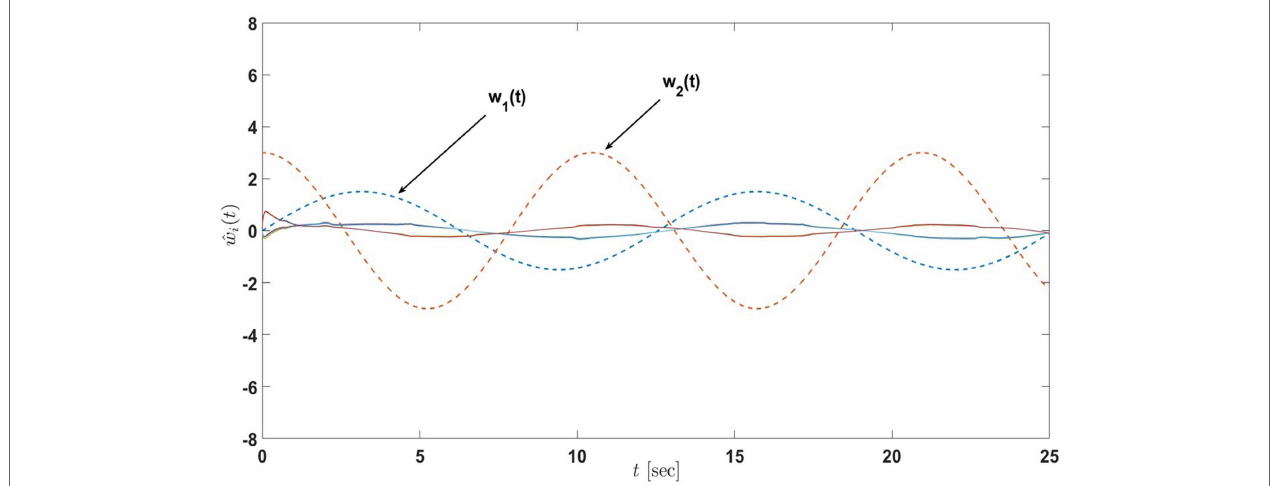
FIGURE 21 | Input estimates of the active-passive sensor network in Example 5 with 13 nodes under the proposed architecture equations (58) and (59) and satisfying the linear matrix inequalities equations (60) and (61) (the dash lines denote the inputs of the actual process and the solid lines denote the input estimates of nodes).